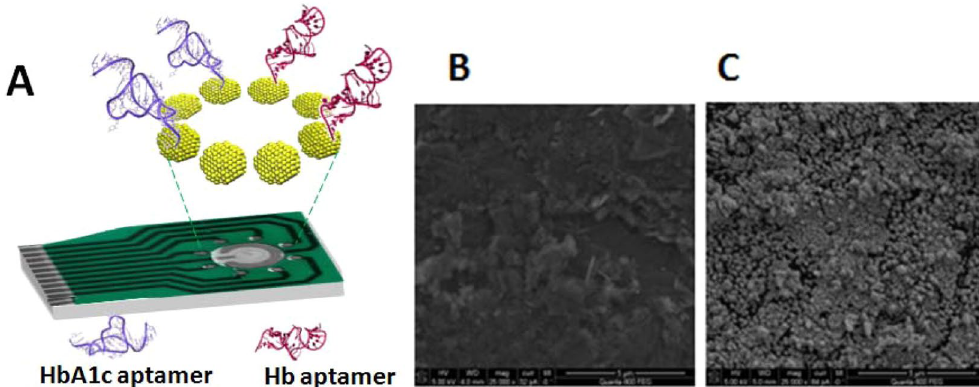
Figure 3. ( A ) Schematic diagram of the aptasensor array platform and scanning electron microscopic image of the screen printed carbon electrodes before ( B ) and after ( C ) AuNPs